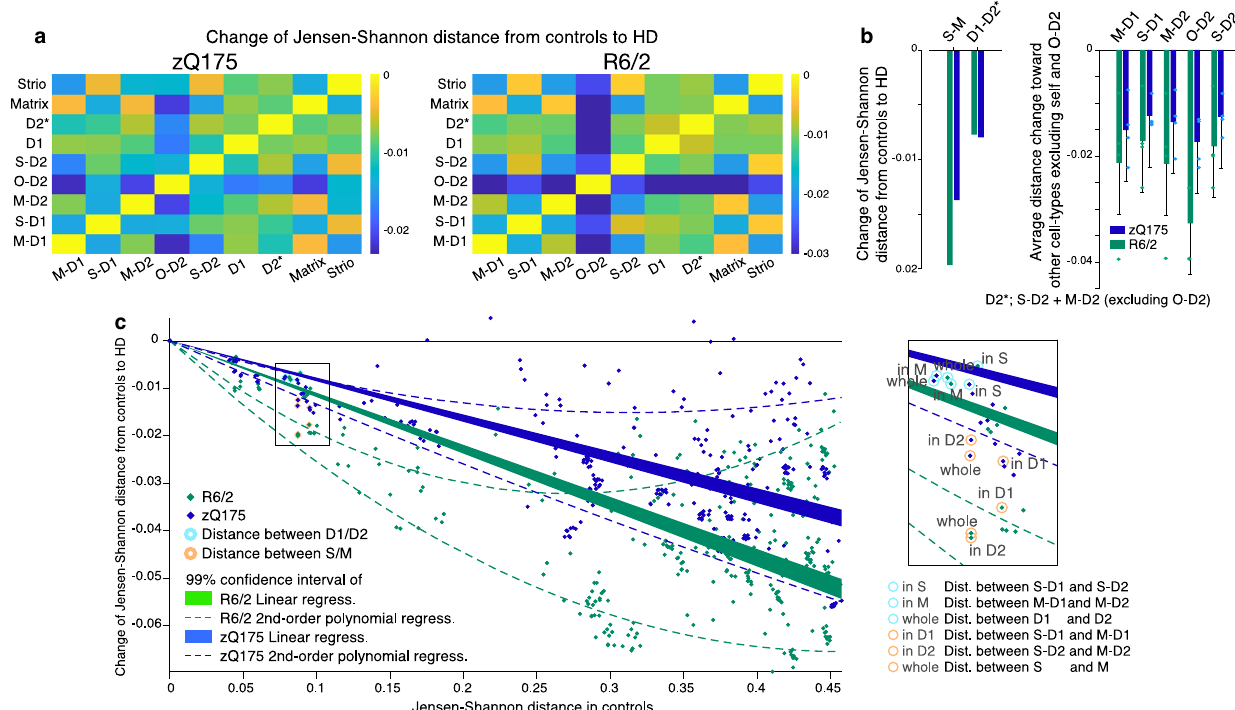
Fig. 2 | Striosome-matrix transcriptomic distinction is more vulnerable than those of D1-D2 in HD. a Jensen-Shannon distances between pairs of cell types for zQ175 (left) and R6/2 (right) as compared to control. Negative values indicate loss of transcriptomic distinction. b Summary of loss of transcriptomic distinctions measuredbyJensen-Shannondistance.Distinctionbetweenstriosomesandmatrix (S-M) and between dSPN and iSPN (D1-D2*) are shown. Right: Loss of distinction between each pair of cell-types. Blue (zQ175) and green (R6/2) bars indicate aver- age loss of distances from each cell-type (labeled above) toward other cell types (excluding self and O-D2). Thus, the numbers of data points are 4 for all SPN subtypes other than O-D2 ( n =3), and all data were plotted as independent mea- sures. D2* does not include O-D2. Error bars indicate 95% con fi dence intervals.